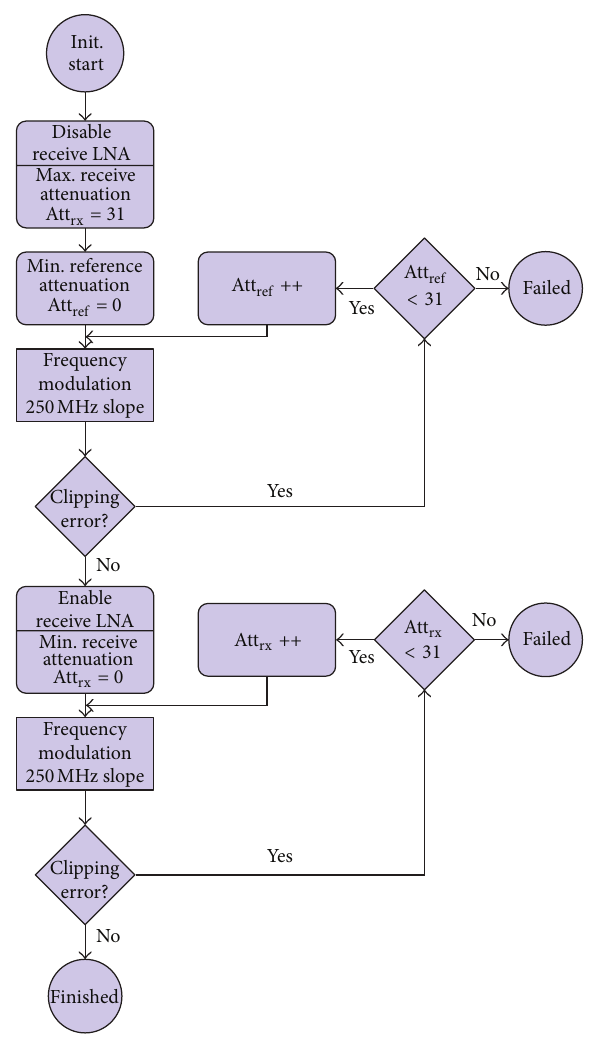
Figure 4: Initialization diagram.